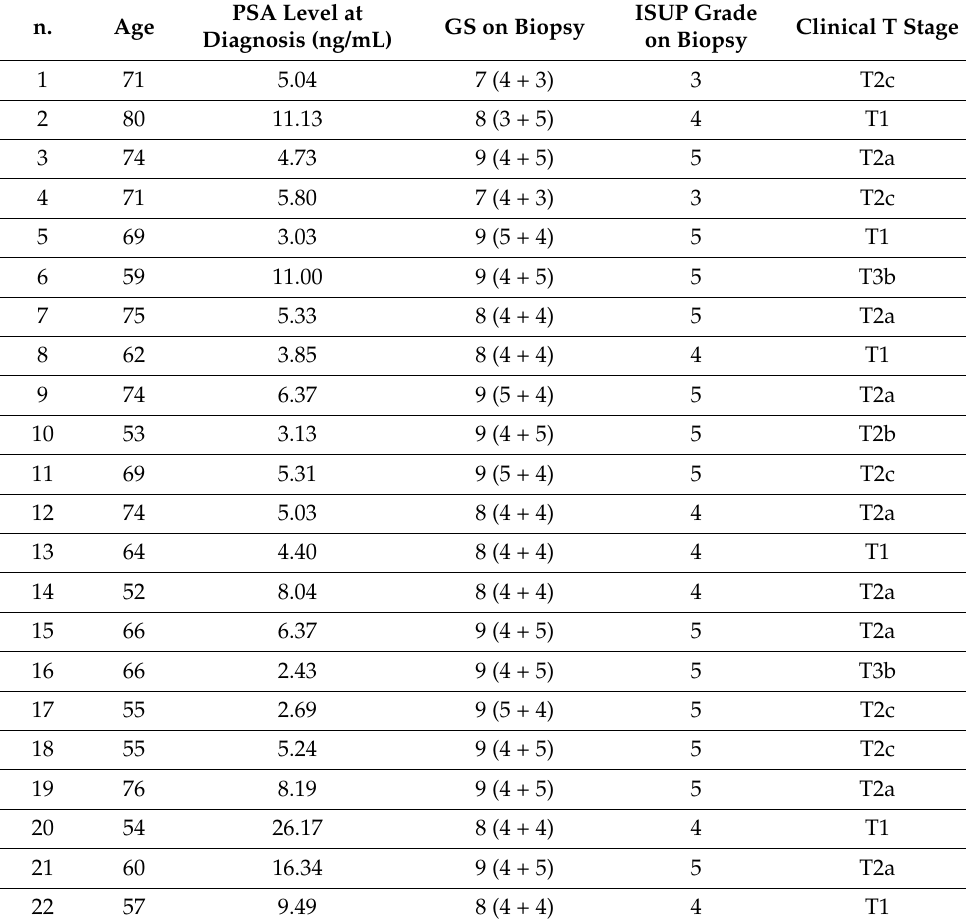
Table 1. Patients’